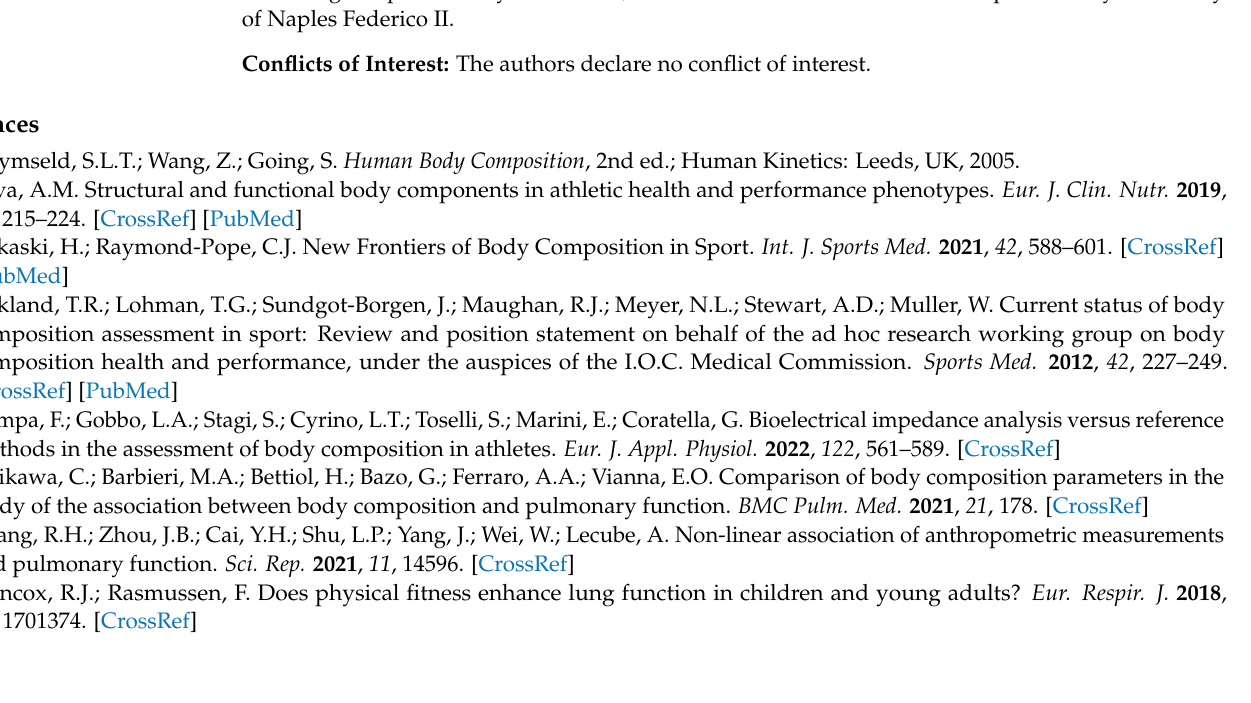
athletes, Table S2. Exercise intensity and spirometry parameters in all population, Table S3. Exercise Intensity and spirometry parameters in males, Table S4. Exercise Intensity and spirometry parameters in females, Table S5. Correlation between body composition and spirometry parameters, Table